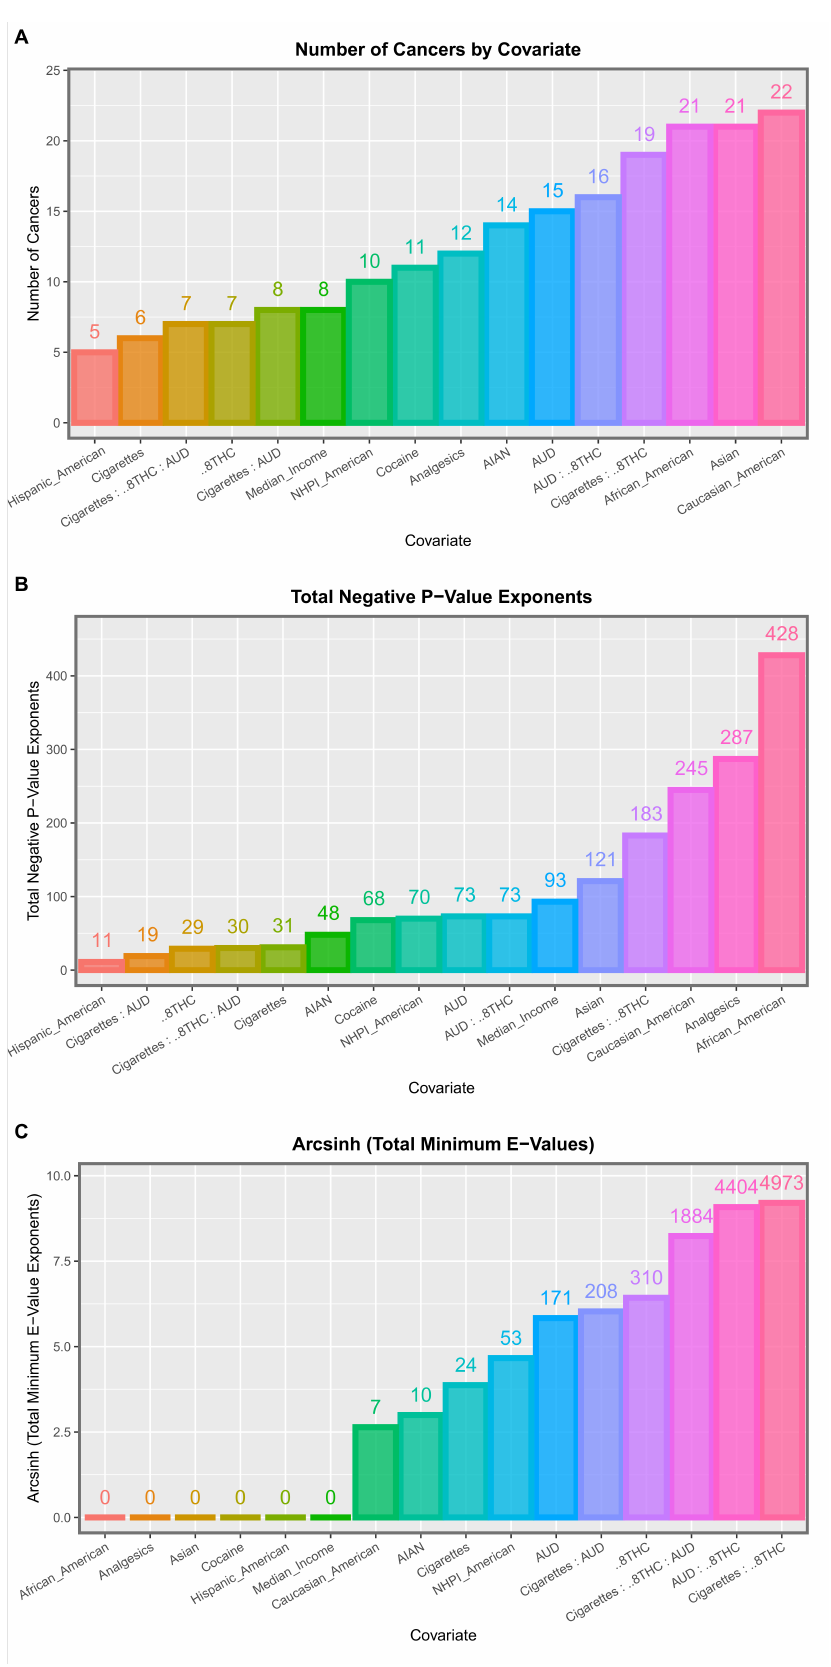
Figure 3. Summary graphs for the interactive multivariable panel models. Please see text for